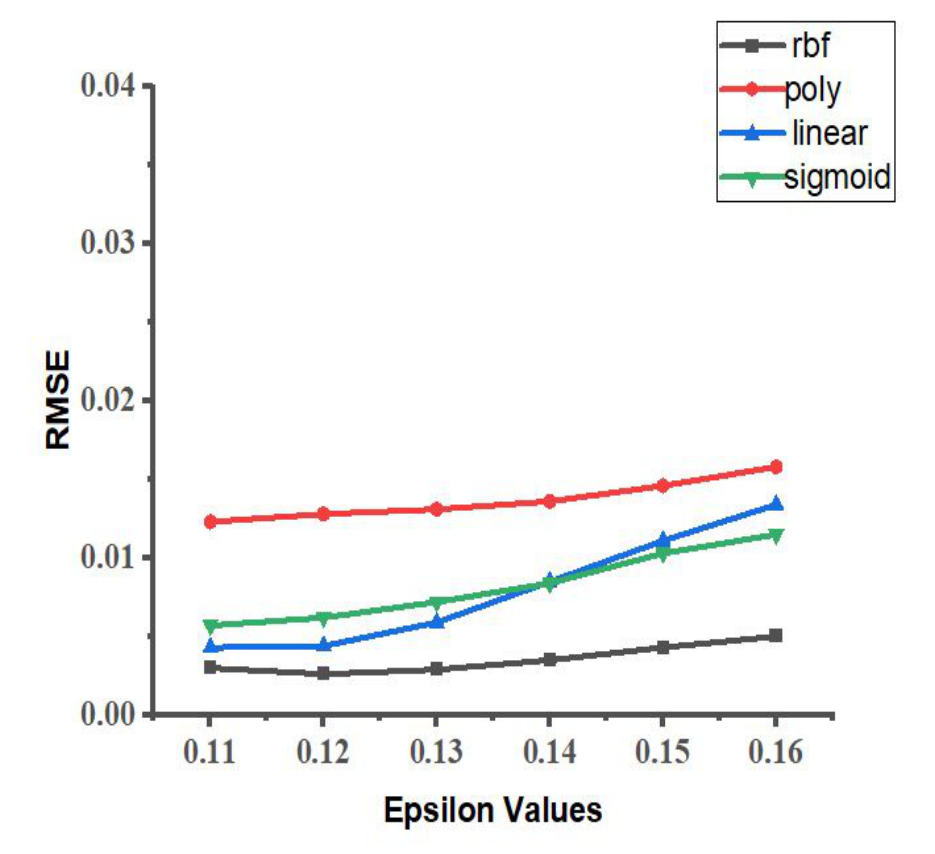
Figure 4. Kernel function comparison for 10% humidity.